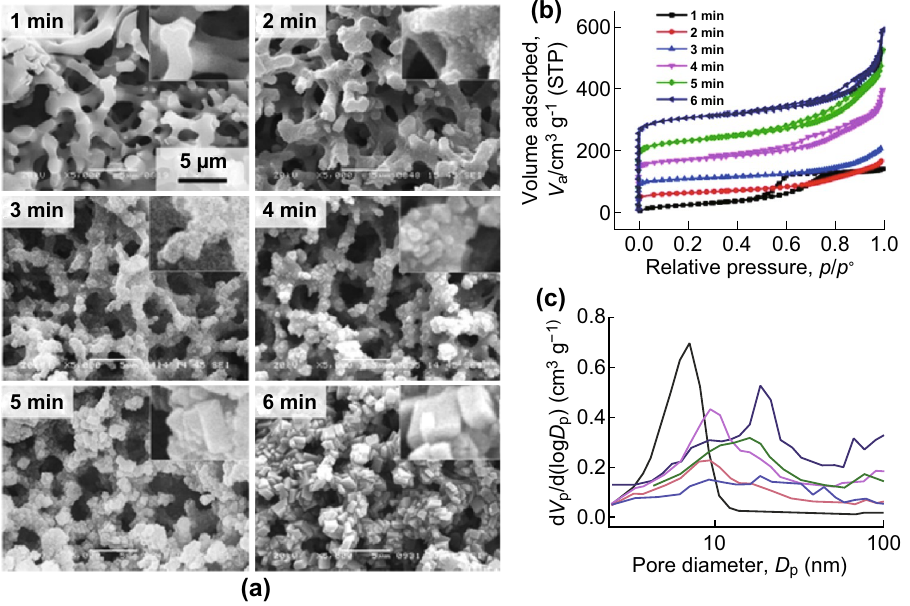
Fig. 8 a SEM images of the conversion of Cu-06 to HKUST-1 with 1-min time intervals, showing the growth of polyhedral crystallites with the preservation of the co-continuous macroporous gel structure. All the images are in the identical magnification. b N 2 sorption isotherms and c BJH pore size distributions with respect to increased immersion times. The BET surface areas and pore sizes increased with immersion times. Reprinted with permission from Ref. [79]. Copyright 2015 Royal Society of